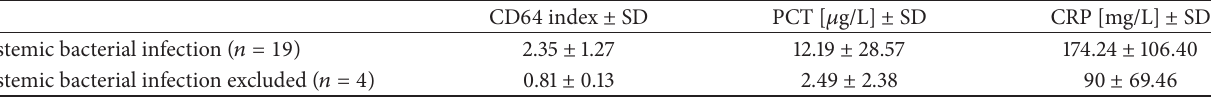
Table 4: Levels of inflammatory biomarkers in patients with and without systemic infection expressed as mean ± standard deviation